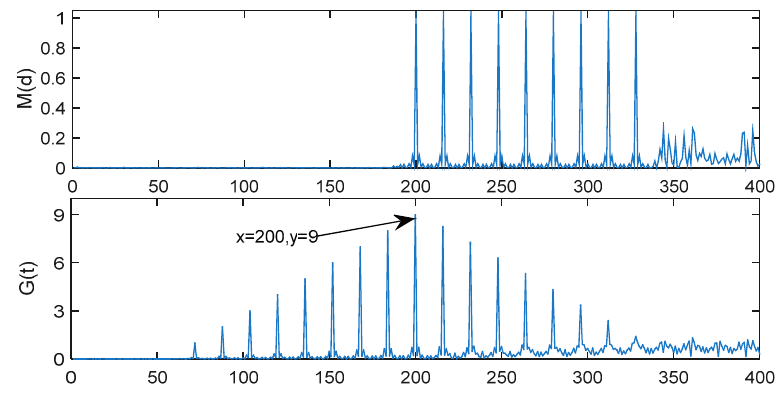
Figure 6. M ( d ) and G ( t ) in ideal